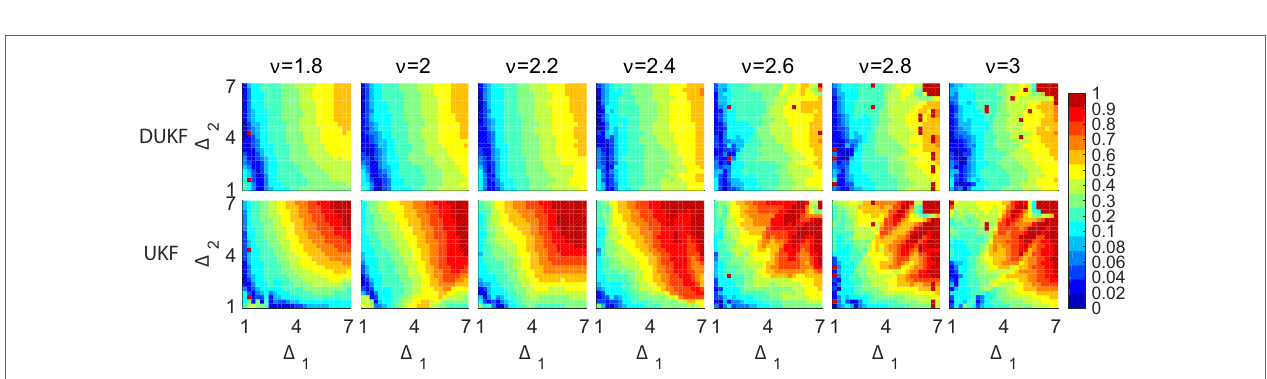
FIGURE 4 | Predictions of the two EKF models for the corresponding parameters of the Bouc–Wen model. (A) 5% noise RMS ratio and corresponding assumed covariances. (B) Varying the noise RMS ratio and assumed covariances.